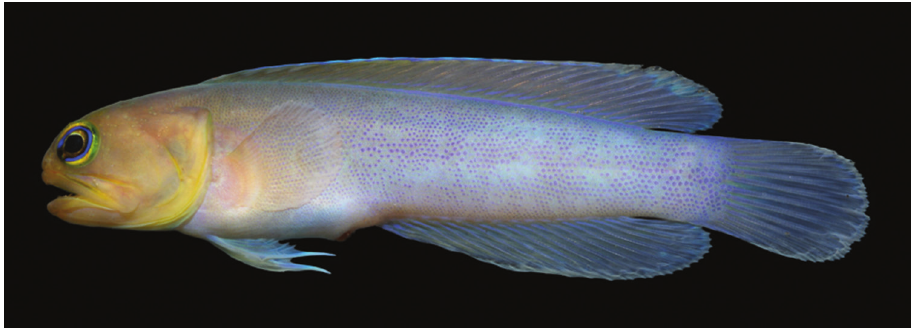
Figure 20. Opistognathus aff. aurifrons , CIUFES 2551, 69.2 mm SL, Fernando de Noronha Archipelago, Brazil. Photograph by Raphael M. Macieira.